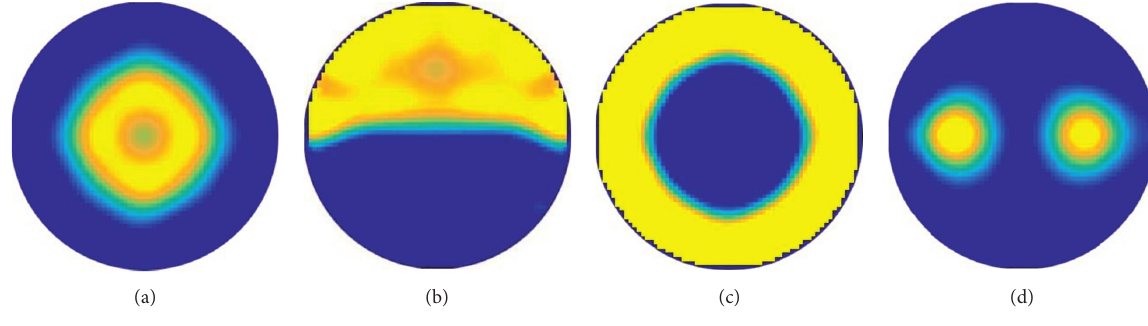
Figure 5: Medium distribution generated by Landweber algorithm. Table 4: Effect of the number of batch samples on the treatment